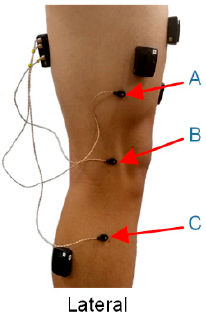
Figure 2. The placement of the Codamotion markers.